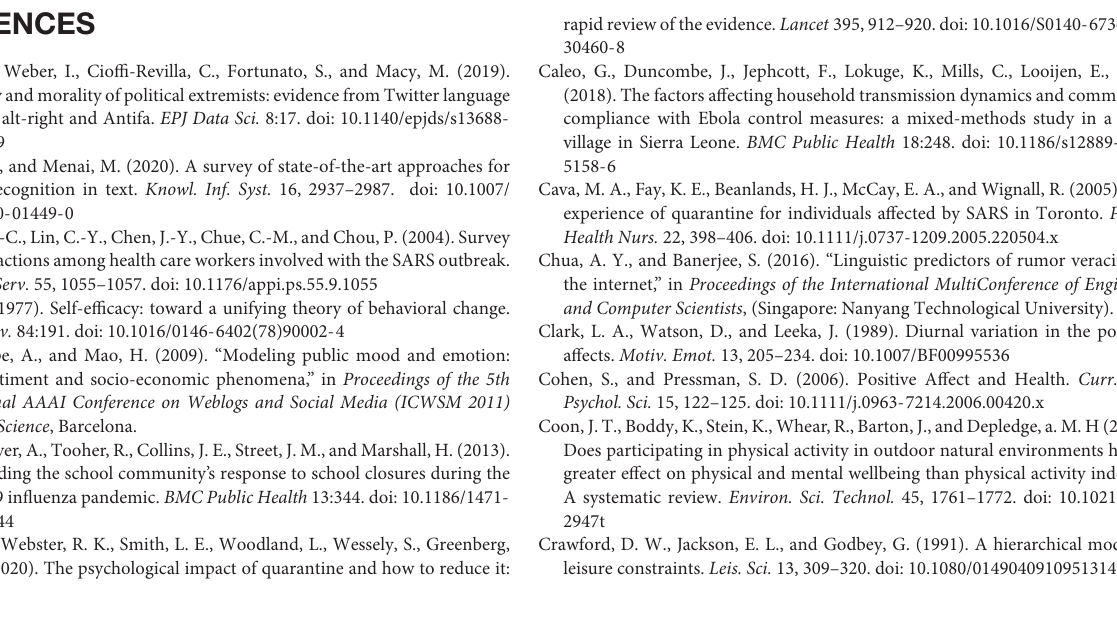
Supplementary Figure 1 | The flow chart of sample filtering and grouping